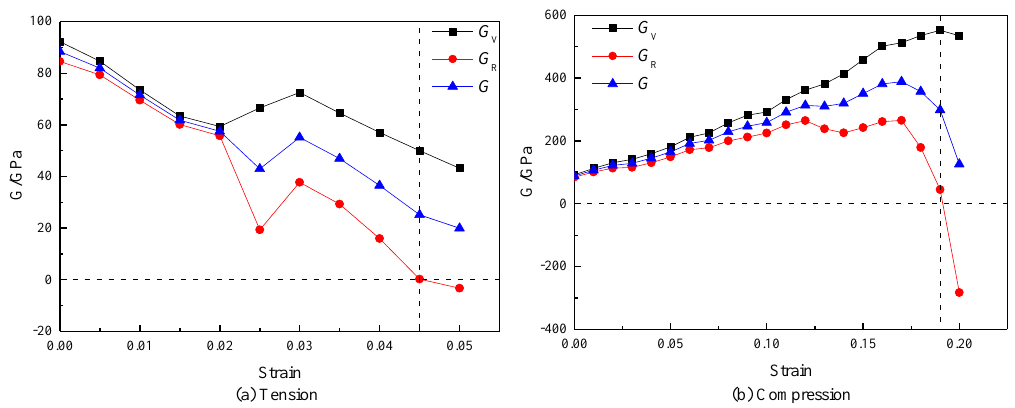
Figure 3. The change of shear modulus in the process of tension and compression. ( a ) tension, and ( b ) compression.